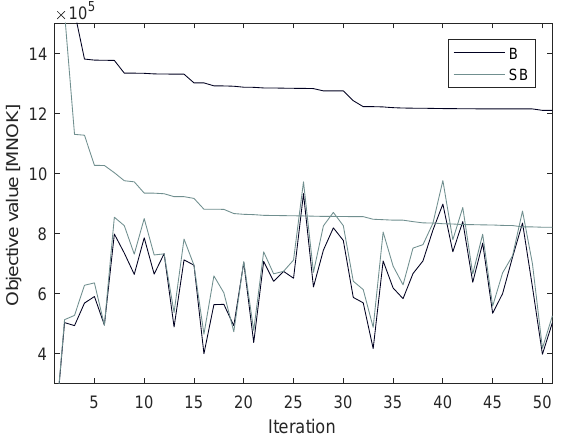
Figure 6. Convergence of the approach with Benders and strengthened Benders cuts. Table 1. Economic and computational performance of the two case studies with use of either B or SB cuts. Uncertainty of inflow, reserve capacity, and energy price (top) and uncertainty of inflow (bottom). UB stat. LB Gap Time